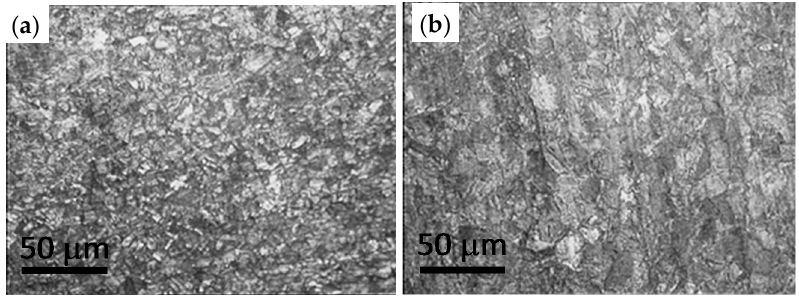
Figure 1. Optical micrographs of: ( a ) chemically etched sample 0; and ( b ) chemically etched sample 1. Table 2. Average grain size determined from the optical micrographs.